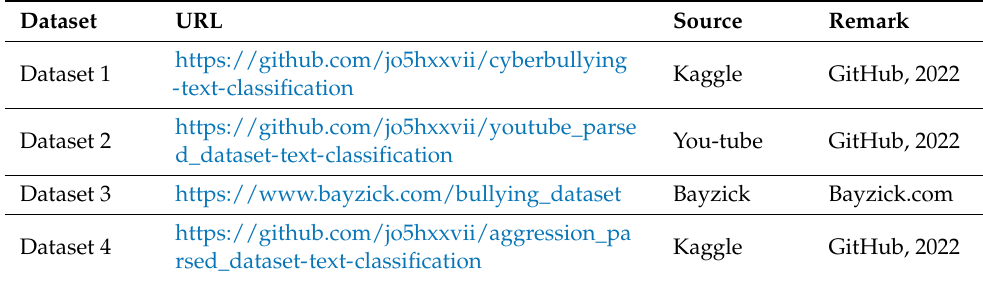
Table 2. Dataset